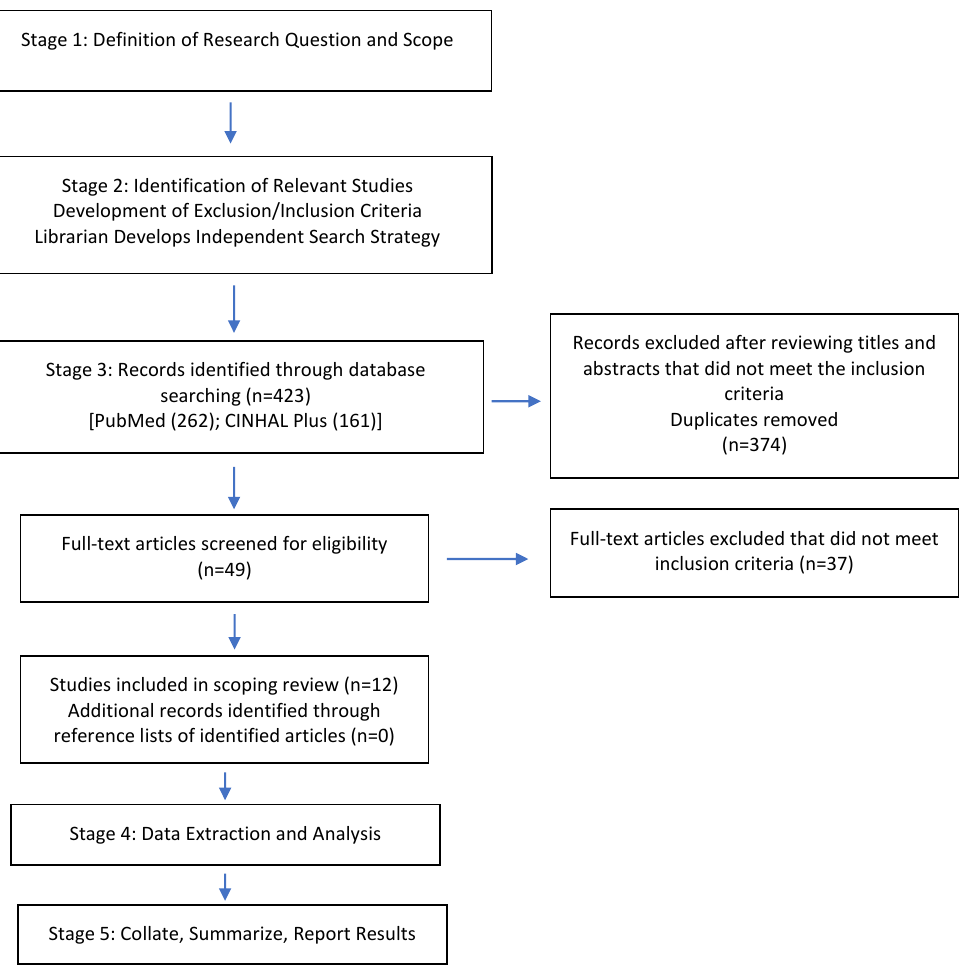
Figure 1. Stages of the scoping literature review.